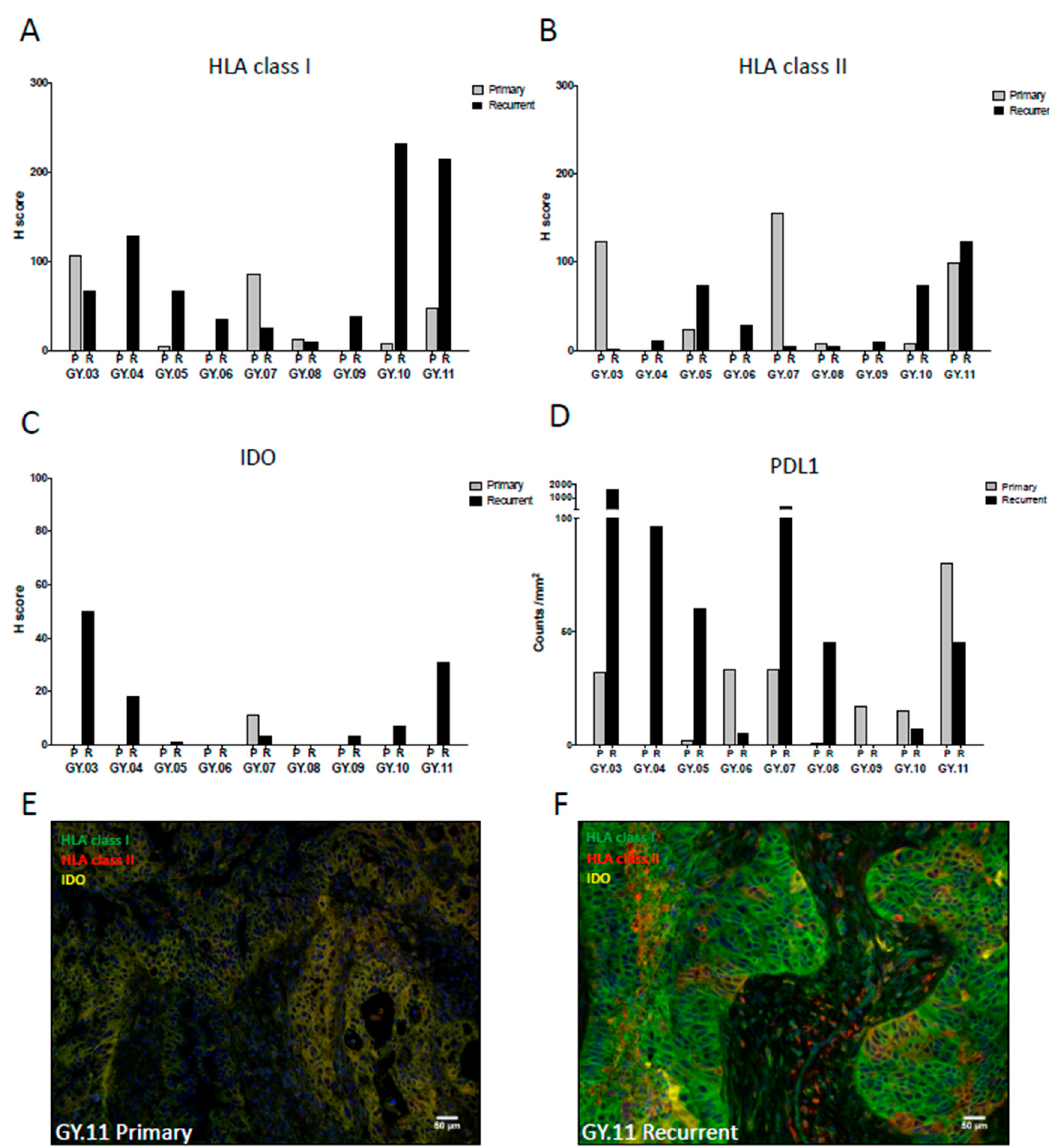
Figure 2. The expression of immune-modulating molecules on tumor cells in the TME of the primary (P) and recurrent (R) tumor samples were analyzed using multispectral immunohistochemistry (IHC) analysis or immunofluorescent IHC. ( A – D ) expression in primary tumor is presented in light grey and expression in recurrent tumor is presented in black. ( A ) Expression of HLA class I in the epithelial compartment of the TME. ( B ) HLA class II in the epithelial compartment of the TME. ( C ) Expression of IDO in the epithelial compartment of the TME. ( D ) Expression of PDL1 (CD163-PD1-PDL1 + ). ( E , F ) Example of HLA and indoleamine 2,3-dioxygenase (IDO) expression in primary ( E ) and recurrent ( F ) tumor tissue in patient GY.11. HLA class I in green, HLA class II in red, and IDO in yellow.